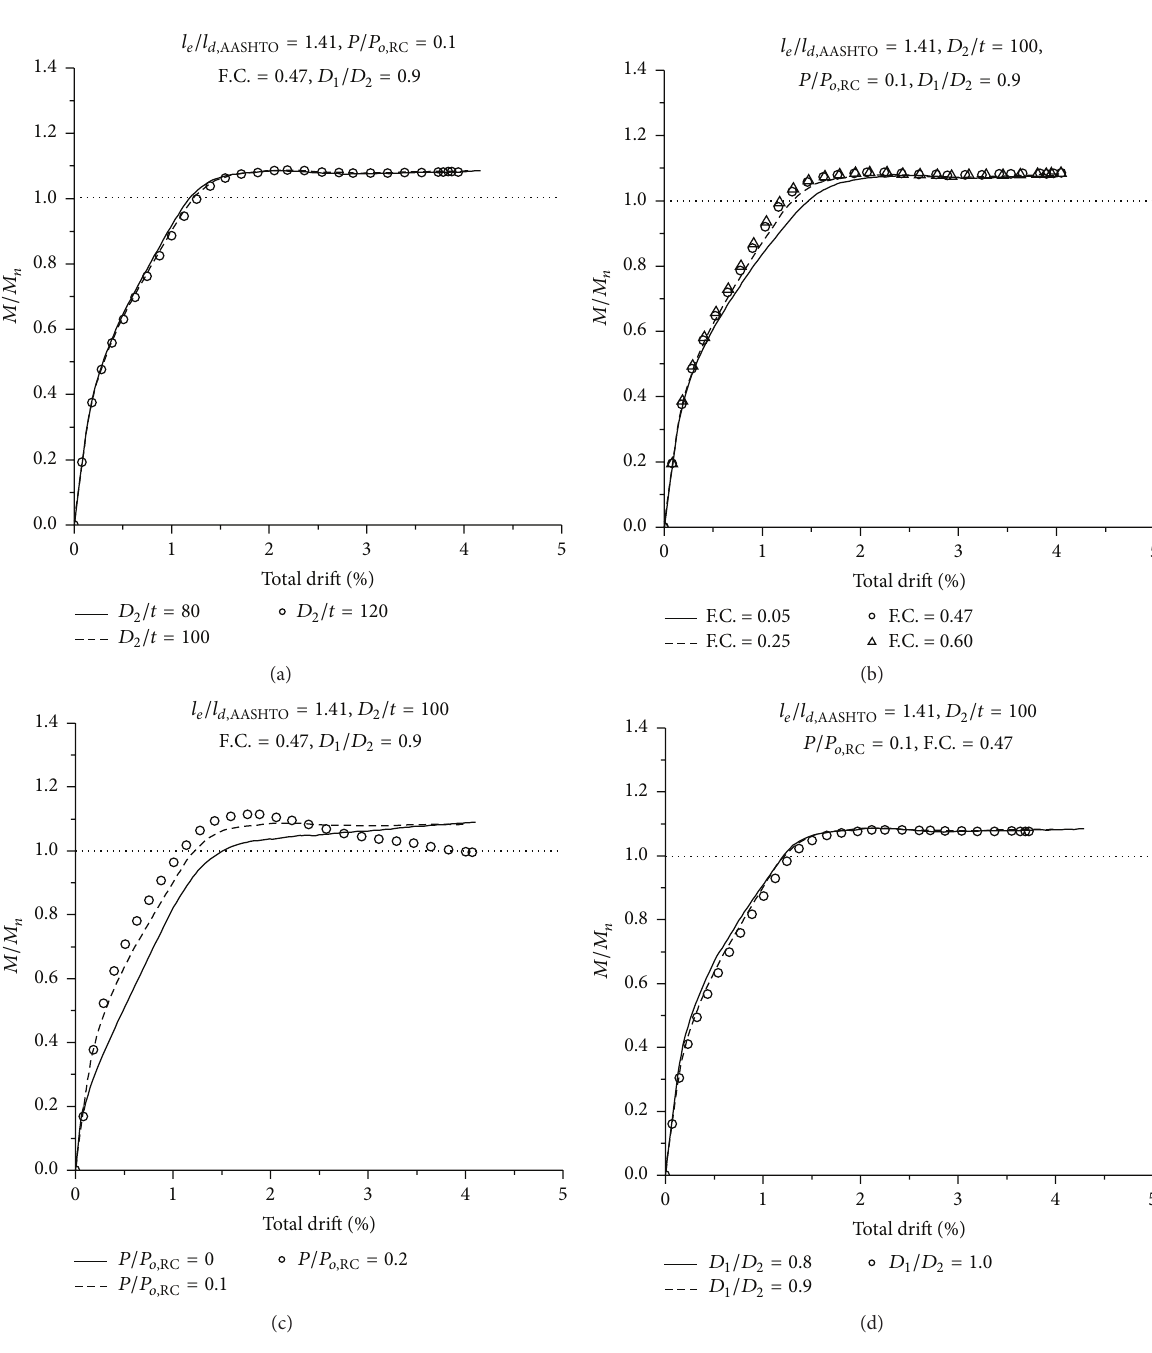
Figure 12: Results of parametric study ( 𝑙 𝑒 /𝑙 𝑑, AASHTO = 1.41 ): (a) effect of 𝐷 2 /𝑡 ratio; (b) effect of friction coefficient; (c) effect of axial load ratio; and (d) effect of 𝐷 1 /𝐷 2